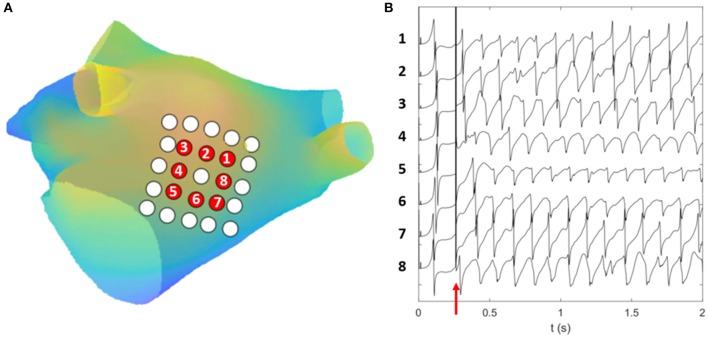
Simulated EGM signals. (A) Computational geometry with the 25 electrodes of the 6 mm grid catheter. Electrodes for which the EGM signals are displayed are colored in red. They are numbered in counter-clockwise order following the direction of rotation of the simulated rotor. (B) The simulated EGM signals computed for the electrodes colored in red on the first 2 s of Simulation Inferior. The y axis of (B) reports the electrode number. The red arrow in (B) indicates the time at which the extra stimulus was applied to induce reentry.